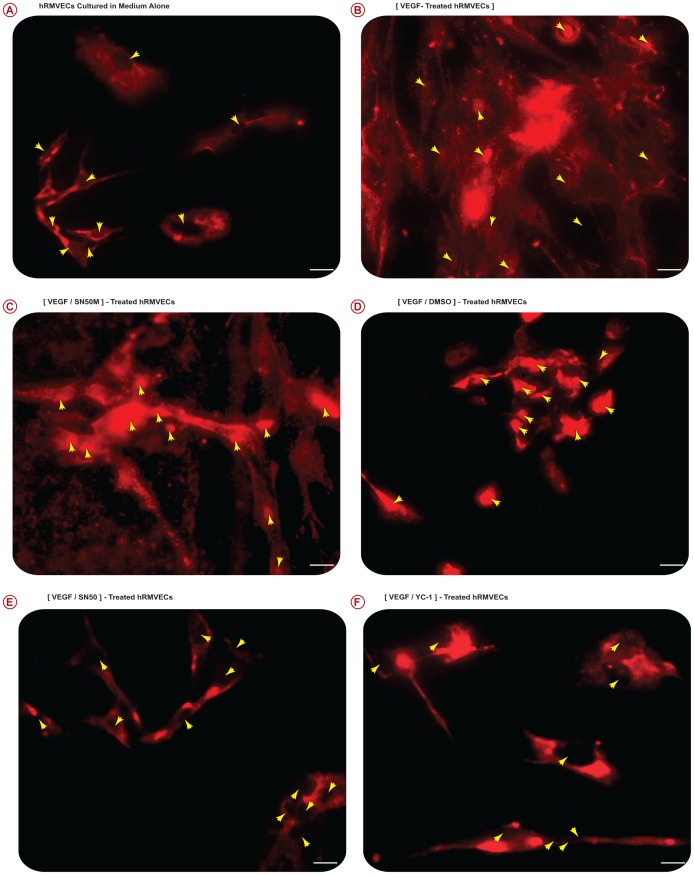
YC-1 Impairs VEGF-Induced Nuclear Translocation of NFκB. A–F. Immunofluorescence Analysis.hRMVECs were incubated for 8 hours under various conditions and were subsequently fixed for immunocytochemistry. The staining intensity and the subcellular localization of NFκB/p65 were determined by immunofluorescence microscopy using anti-NFκB/p65 antibody. Photomicrographs, which exhibit intense nuclear and/or cytoplasm staining was considered a positive signal. Cells that were stimulated with VEGF alone (B), or incubated with either VEGF/SN50M (C) or VEGF/DMSO (D); exhibited high levels of NFκB/p65 immunoreactivity, which was preferentially localized in the nuclei of the cells. In addition, there was a positive intense staining signal of NFκB/p65 deposited over the cytoplasms and nuclei of the cells of these groups. Treatment of cells with SN50 [20 uM] or YC-1 [100 uM] resulted in a significant and almost complete inhibition of NFκB/p65 nuclear translocation. Images are representatives of three independent experiments. Scale bars, 200 mm.